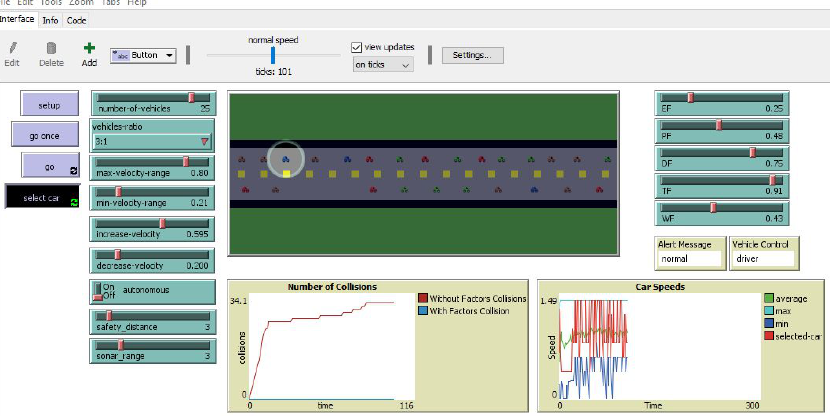
Figure 10. Main Interface of Simulation with Control in Driver